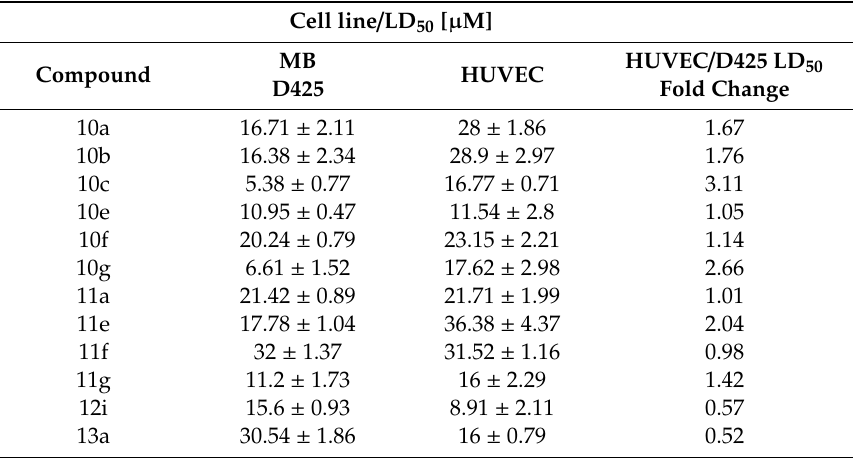
Table 2. LD 50 values for designated sulfonamides tested in D425 and HUVEC